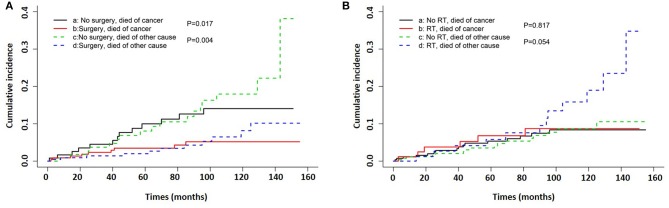
Competing risk curve of cancer-specific survival for patients with mucinous PCa. (A) competitive risk model of surgery, (B) competitive risk model of radiation therapy.